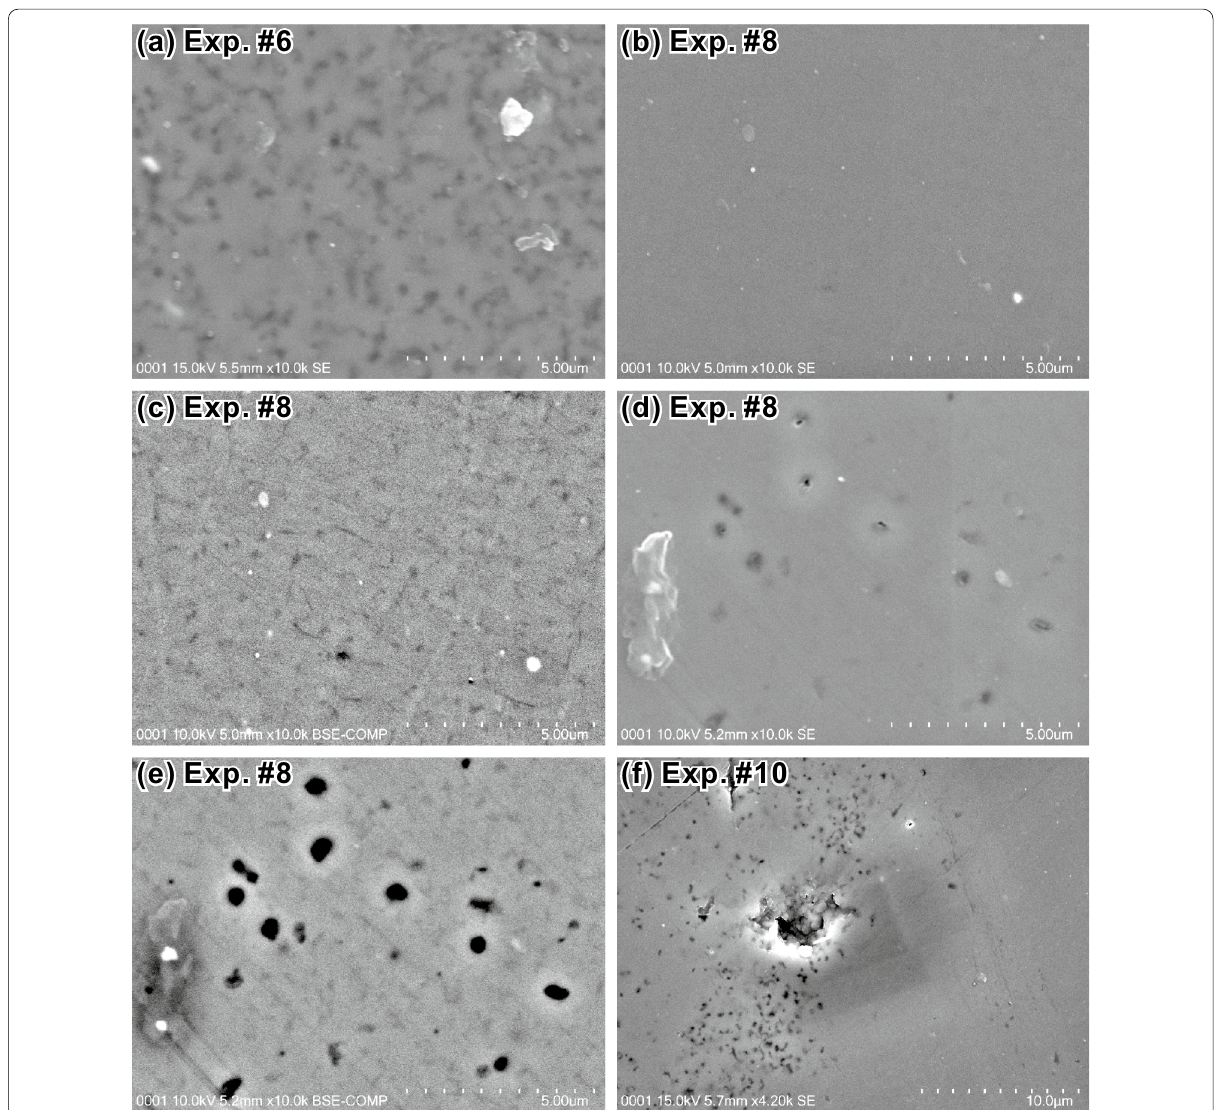
Fig. 8 SEM images of hot‑pressed samples prepared from the powders after hours of decantation without CAS conditions. a SEI of the sample that was hot‑pressed for 17 h at 1100 °C and 50 MPa (Exp. #6). b SEI of the sample that was hot‑pressed for 100 h at 1100 °C and 50 MPa (Exp. #8). c BEI of the same place as ( b ). d SEI of the sample that was hot‑pressed for 100 h at 1100 °C and 50 MPa and was mottled white (Exp. #8). e BEI of the same place as ( d ). f SEI of the sample that was hot‑pressed for 18 h at 1080 °C and 100 MPa (Exp. #10). The left side of the image corresponds to the white mottled area, and the right side of the image corresponds to the black mottled